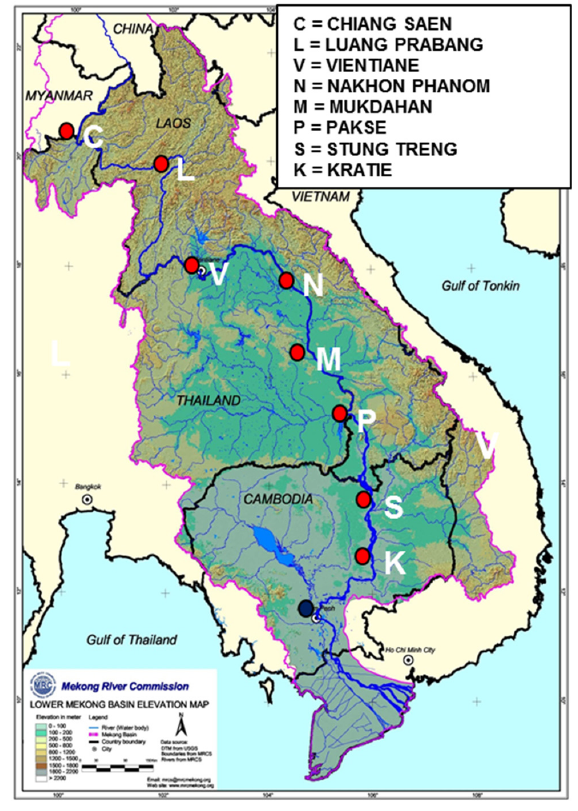
Figure 1. Middle reach of the Mekong, showing gaging stations (with permission of Mekong River Commission).